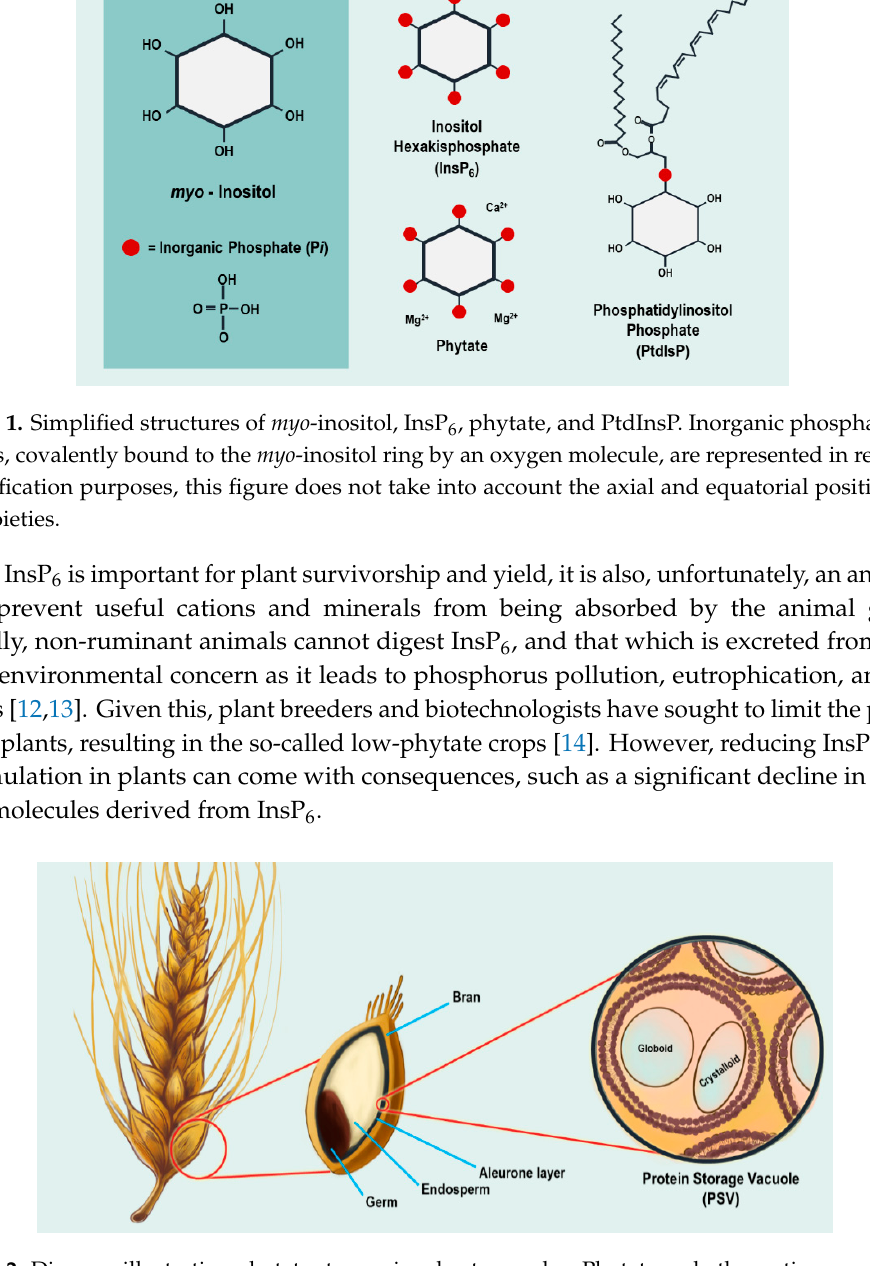
Figure 1. Simplified structures of myo -inositol, InsP 6 , phytate, and PtdInsP. Inorganic phosphate (P i ) groups, covalently bound to the myo -inositol ring by an oxygen molecule, are represented in red. For simplification purposes, this figure does not take into account the axial and equatorial positions of the moieties.